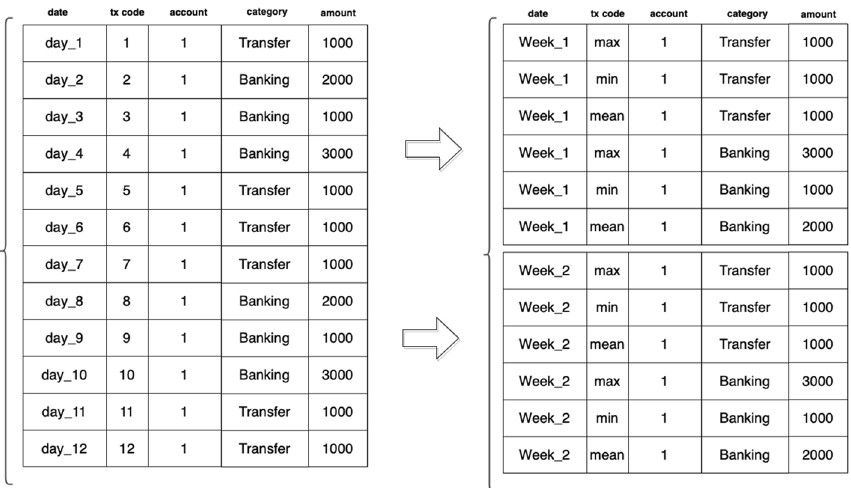
Fig. 3 Example of resampling from days to weeks